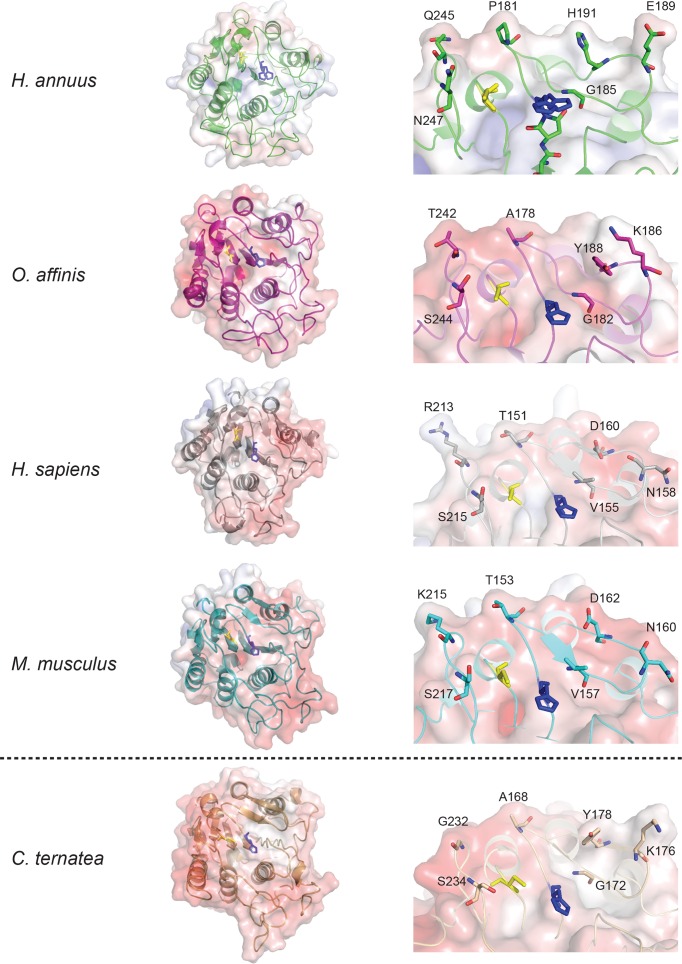
Comparison of crystal structures of AEPs and a model of an efficient macrocyclizing AEP.Crystal structures of AEPs with APBS generated electrostatic potential maps contoured at ±10 kT/e and catalytic Cys and His shown in yellow and blue sticks, respectively. Overall topology of AEPs (left) appear similar with slight differences in surface electrostatic potential. Expanded views of catalytic region (βI sheet, β5-βIV loop and βI-βIII region) orientated over the catalytic His residue (right) illustrates variation around the active site, with residues that are proposed to alter substrate specificity shown with sticks. A model of an efficient macrocyclizer, C. ensiformis AEP (accession code: AIB06797), built on the HaAEP1 structure which displays 76.3% amino acid identity, is shown below the dotted line. C. ensiformis AEP appears to exhibit a more accessible active site, in comparison to other AEP structures, due to the presence of several short side-chain amino acids.